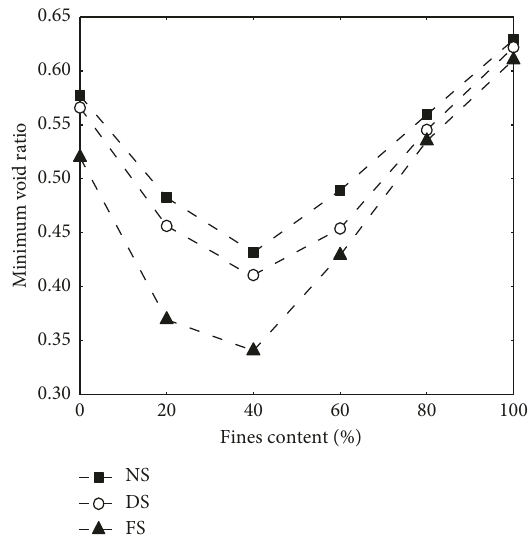
Figure 8: Mixing two groups (1-2mm and 0.1–0.25mm).